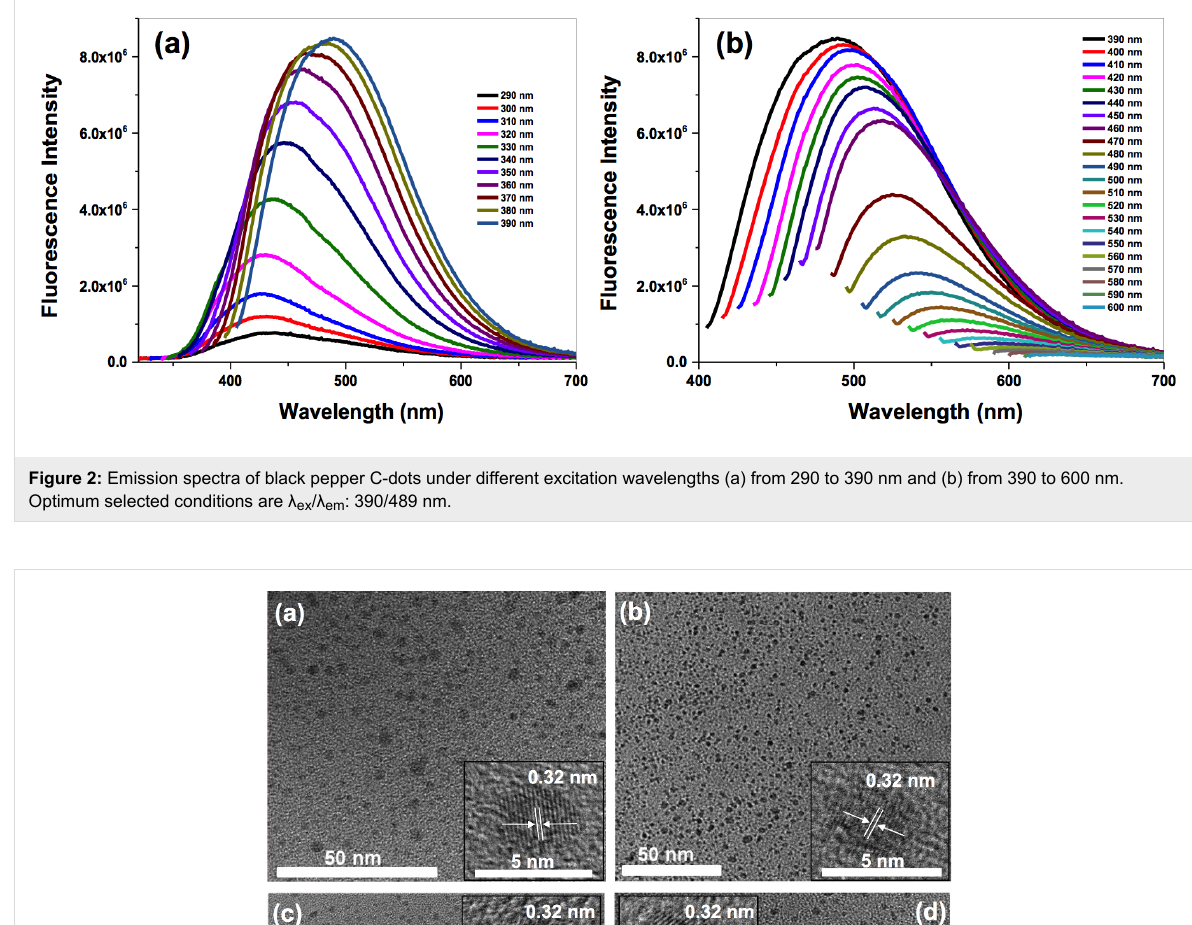
These diffraction peaks match well with the characteristic peaks of graphene oxide [42-44], and they are also in agreement with the HR-TEM lattice distances